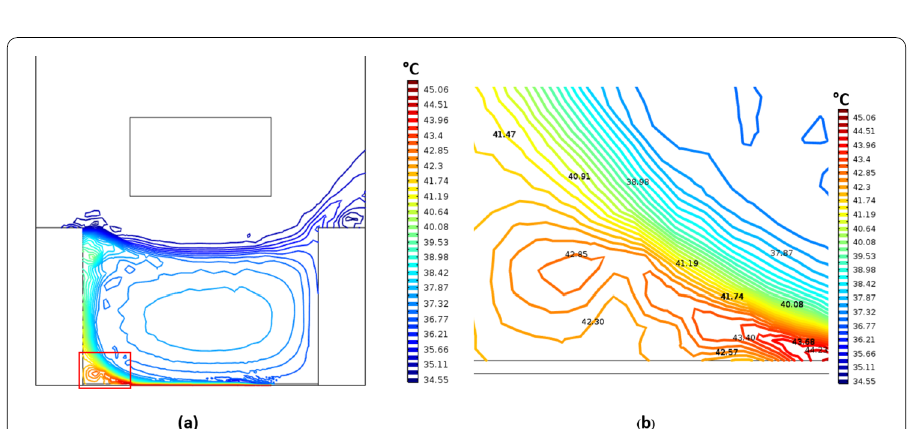
Figure 6 The surface temperature ( ° C) at steady state when u = 25 km/h (strong wind): ( a ) Half of the entire computational domain, and ( b ) Zoom-in of the selected area